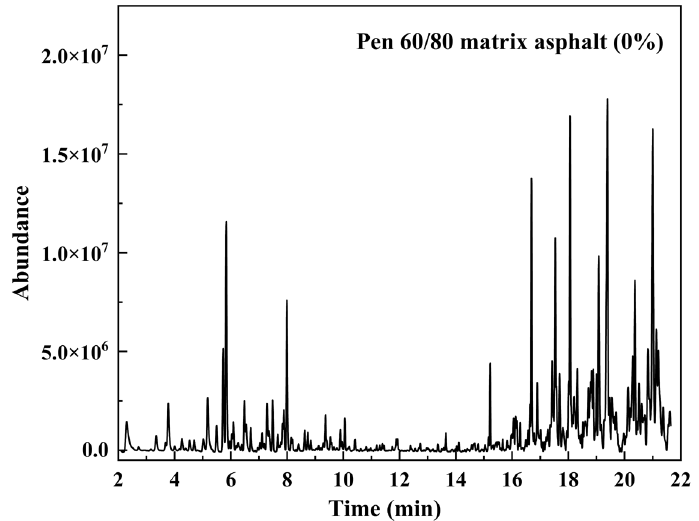
Figure 5. GC-MS pattern of matrix asphalt.